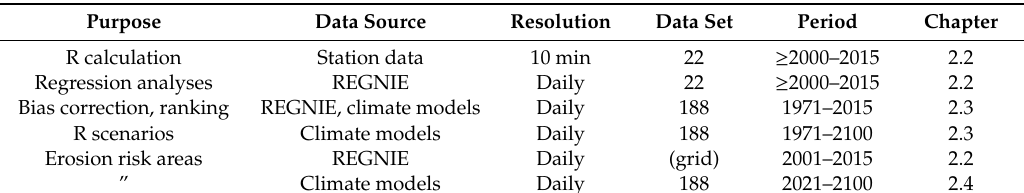
Table 2. Overview of the climate data used in this study. The 188 data points comprise the 22 stations in Table 1. 2001–2015 was the reference period for scenario analyses.